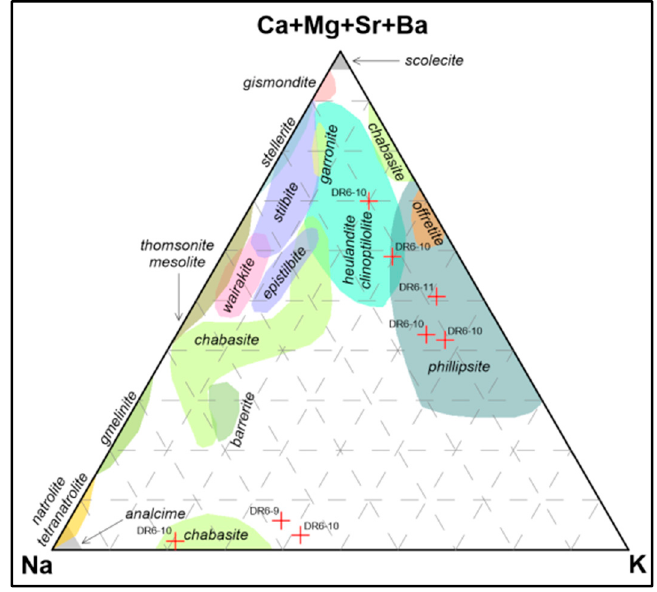
Figure 10. Ternary diagram classification of the DHR zeolites basing on Na, K and ∑ (Ca, Mg, Sr, Ba) ratios. Compiled using References [103] and [104].